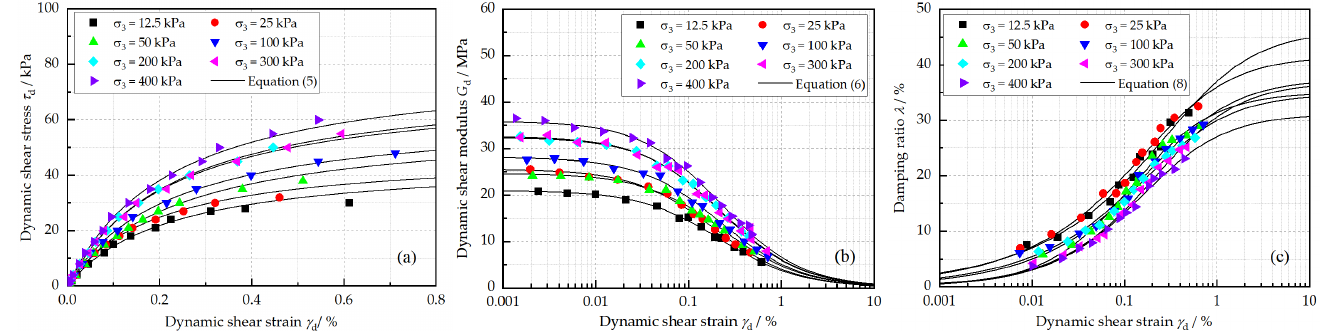
Figure 9. Effects of confining pressure on ( a ) backbone curve, ( b ) dynamic shear modulus, and ( c ) damping ratio under the conditions of N = 5, C FA = 20%, C PF = 0.5% and w =